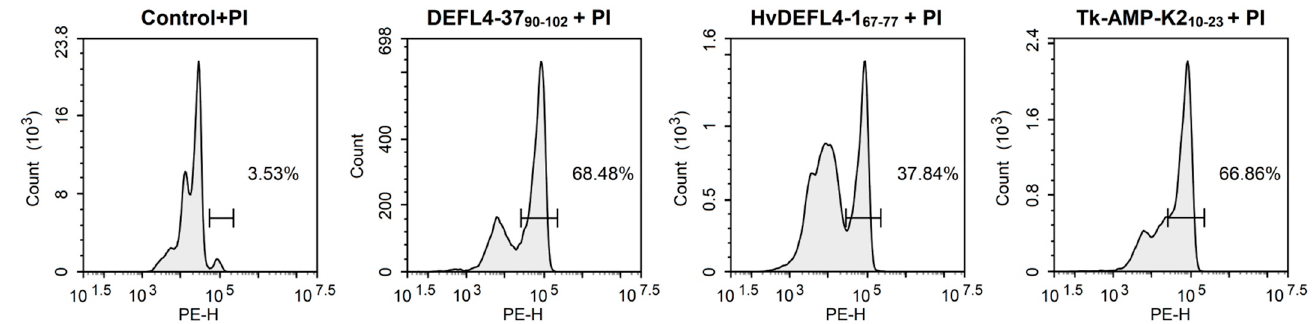
Figure 6. Penetration of propidium iodide (PI) into Cr. neoformans cells treated with peptides at a concentration of 300 μ m. Untreated Cr. neoformans cells were used as a negative control.